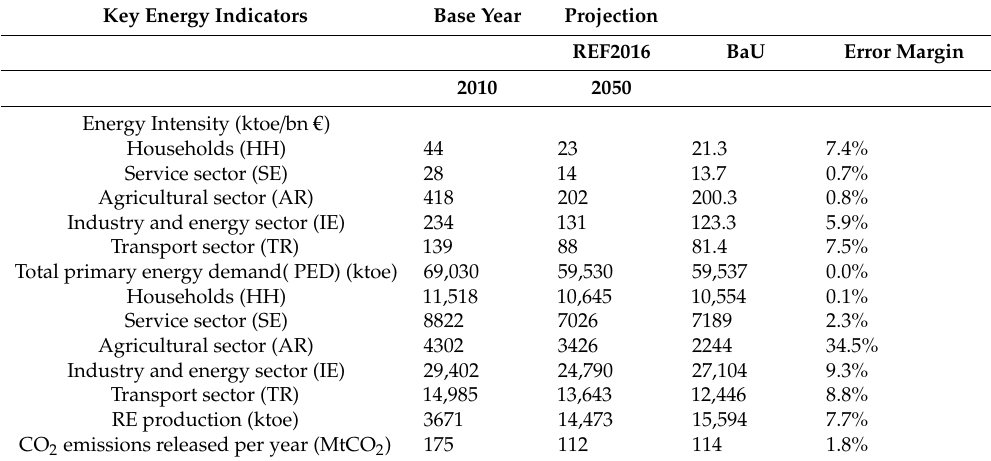
Table 4. Model validation